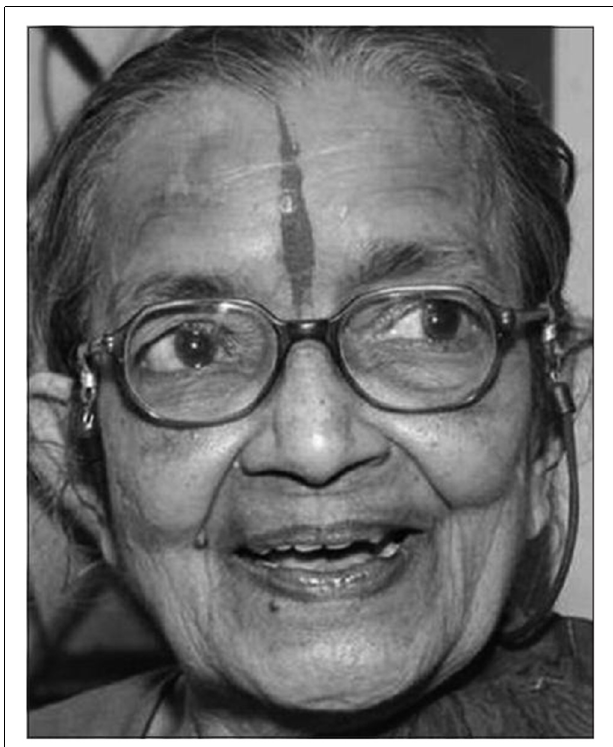
FIGURE 3 | Thanjavur Santhanakakrishna Kanaka, reproduced from Vilanilam et al.